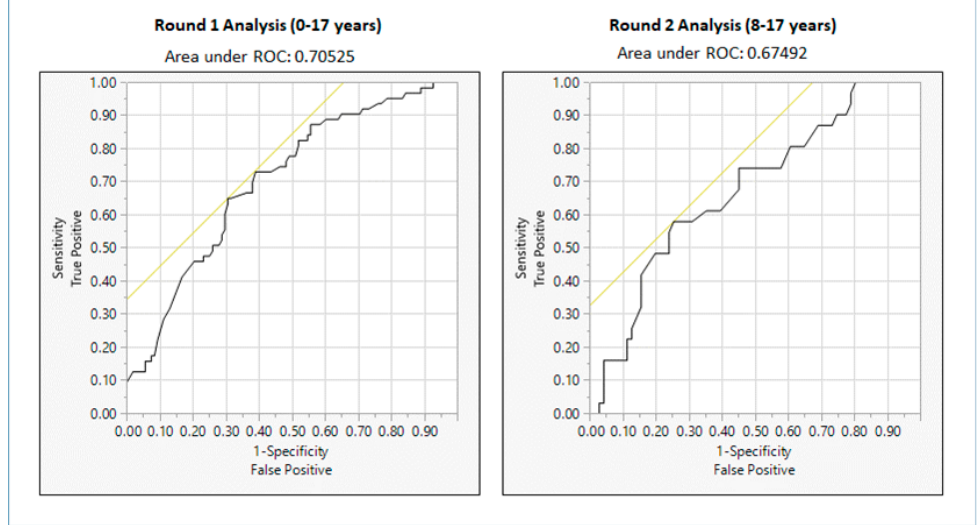
Figure 1. Receiver Operating Characteristic (ROC) curves for Round 1 and Round 2 analysis.